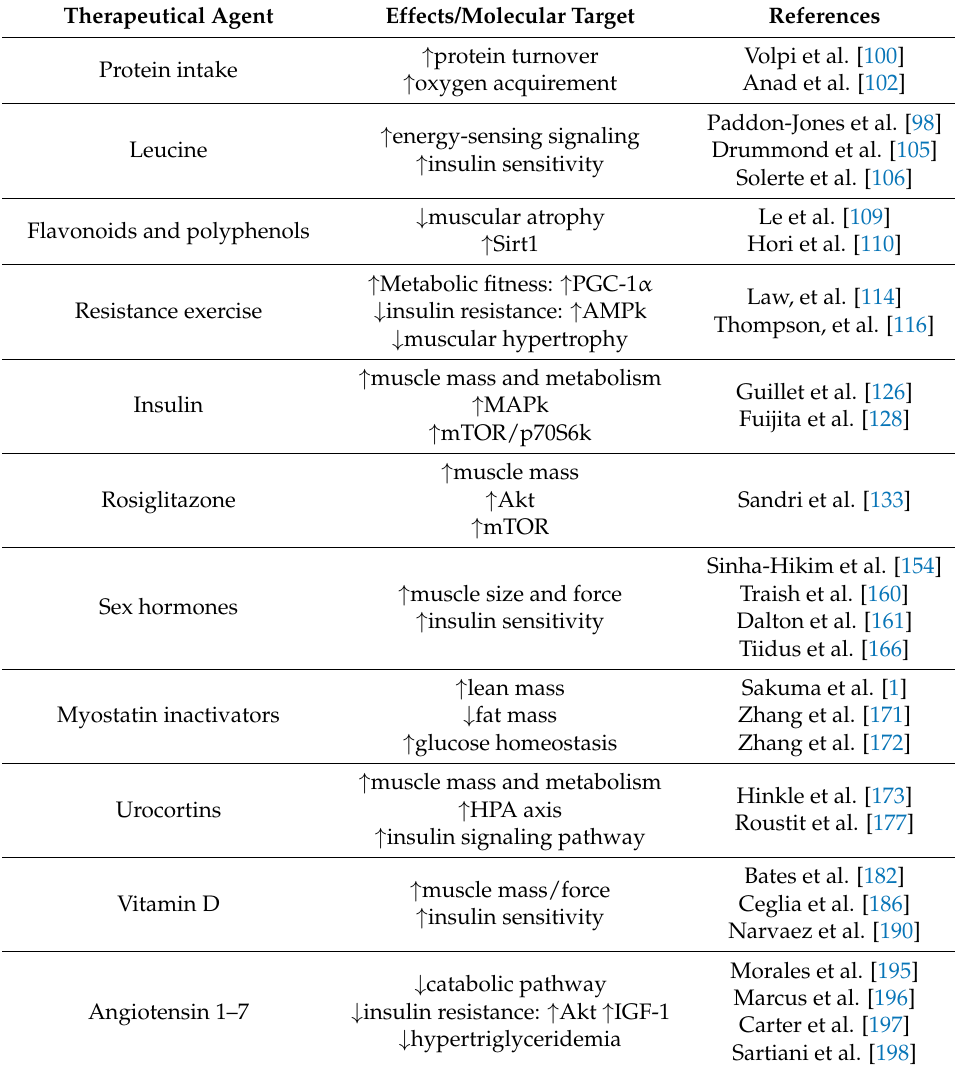
Table 1. The beneficial physiological effects of some treatments for metabolic syndrome-related sarcopenia. ( ↓ ) inhibition, down-regulation, or reduction of activity; ( ↑ ) stimulation, induction, or increase of